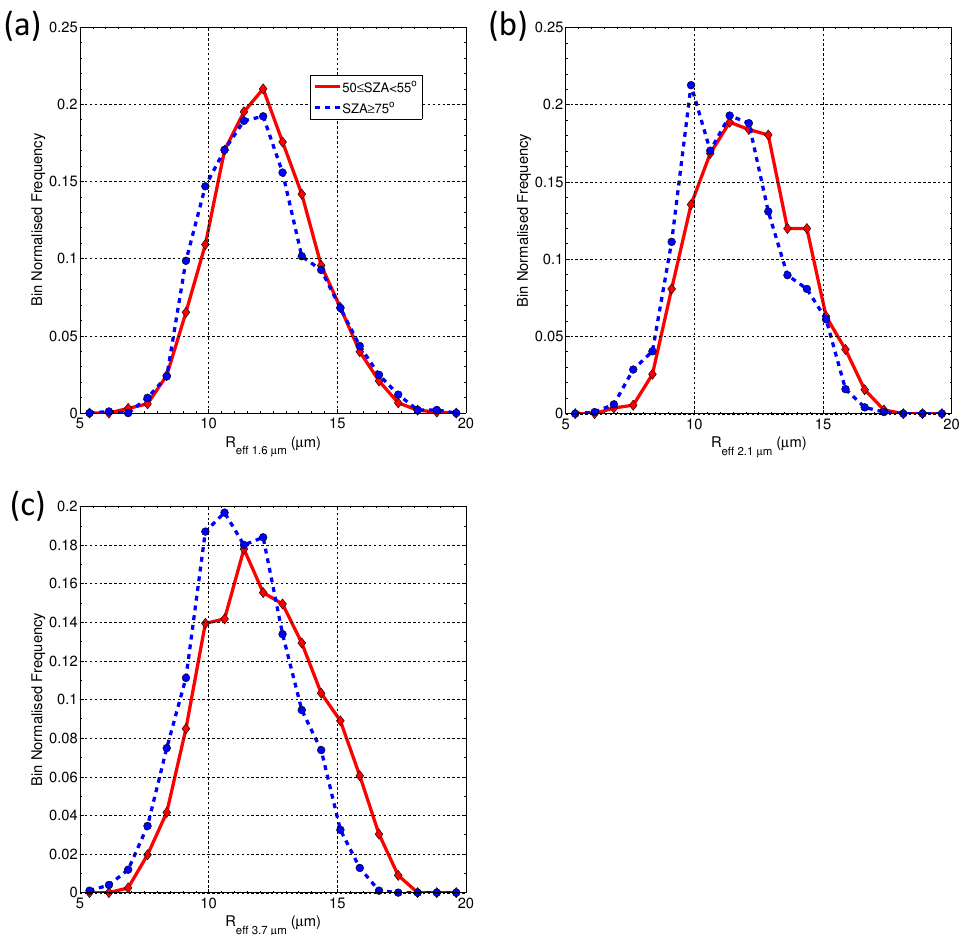
Figure 8. As for Fig. 6 and for r e and that the probabilities are normalized by the bin widths in linear space. Results are shown for the three different MODIS